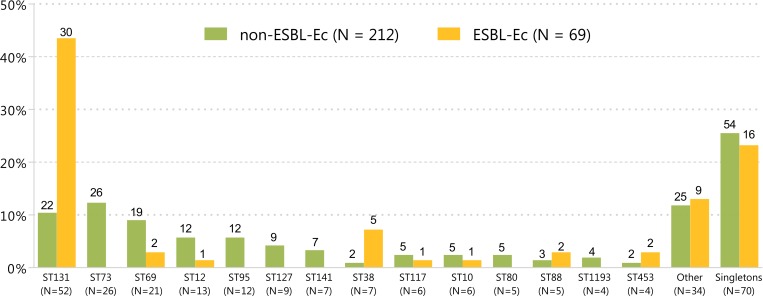
ST distribution among non-ESBL-Ec versus ESBL-Eca in order of frequencyb.ESBL, extended-spectrum beta-lactamase; ESBL-Ec, ESBL-producing E. coli; non-ESBL-Ec, non-ESBL-producing E. coli; ST, sequence type. aESBL-positivity based on phenotypic ESBL production. bMissing STs and STs that occurred ≤3 times are grouped in “Other”. STs that only occurred once are grouped in “Singletons”. The height of each individual bars represents the proportion of the ST within the group of non-ESBL-Ec and ESBL-Ec, respectively. The numbers represent the absolute numbers of occurrence.